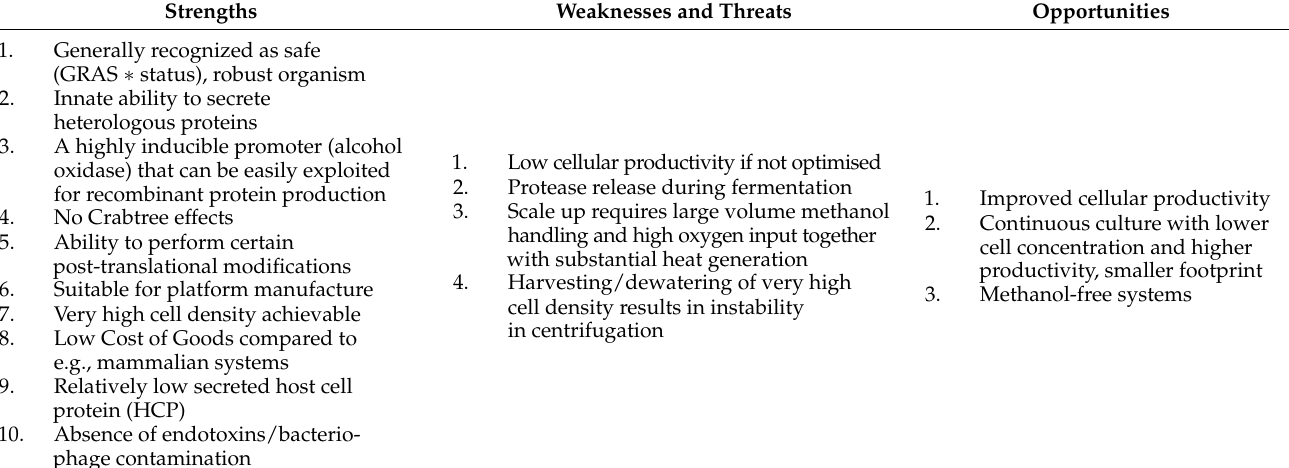
Table 2. SWOT analysis of P. pastoris platform